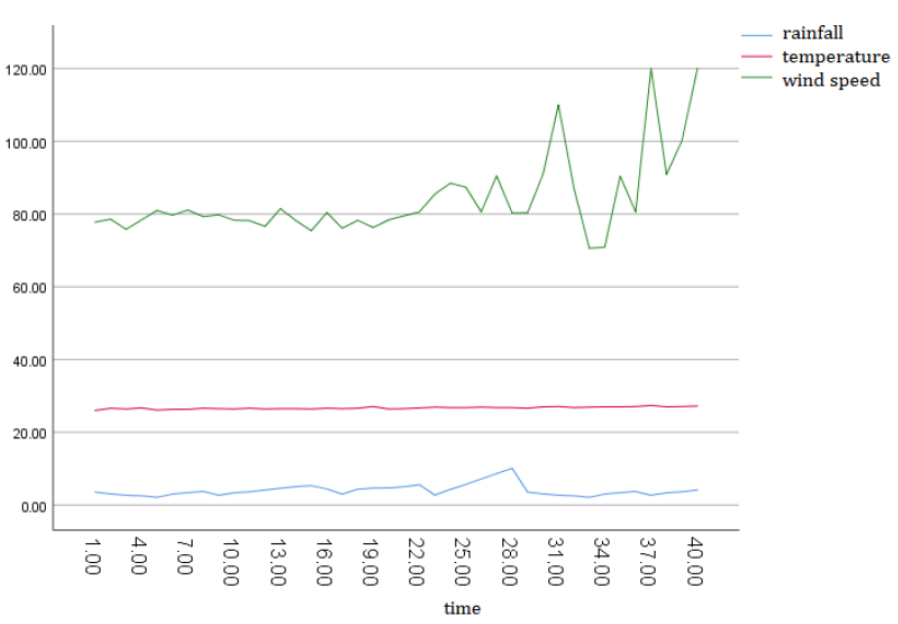
Figure 2. Weather Data in Bandung Regency, West Java.